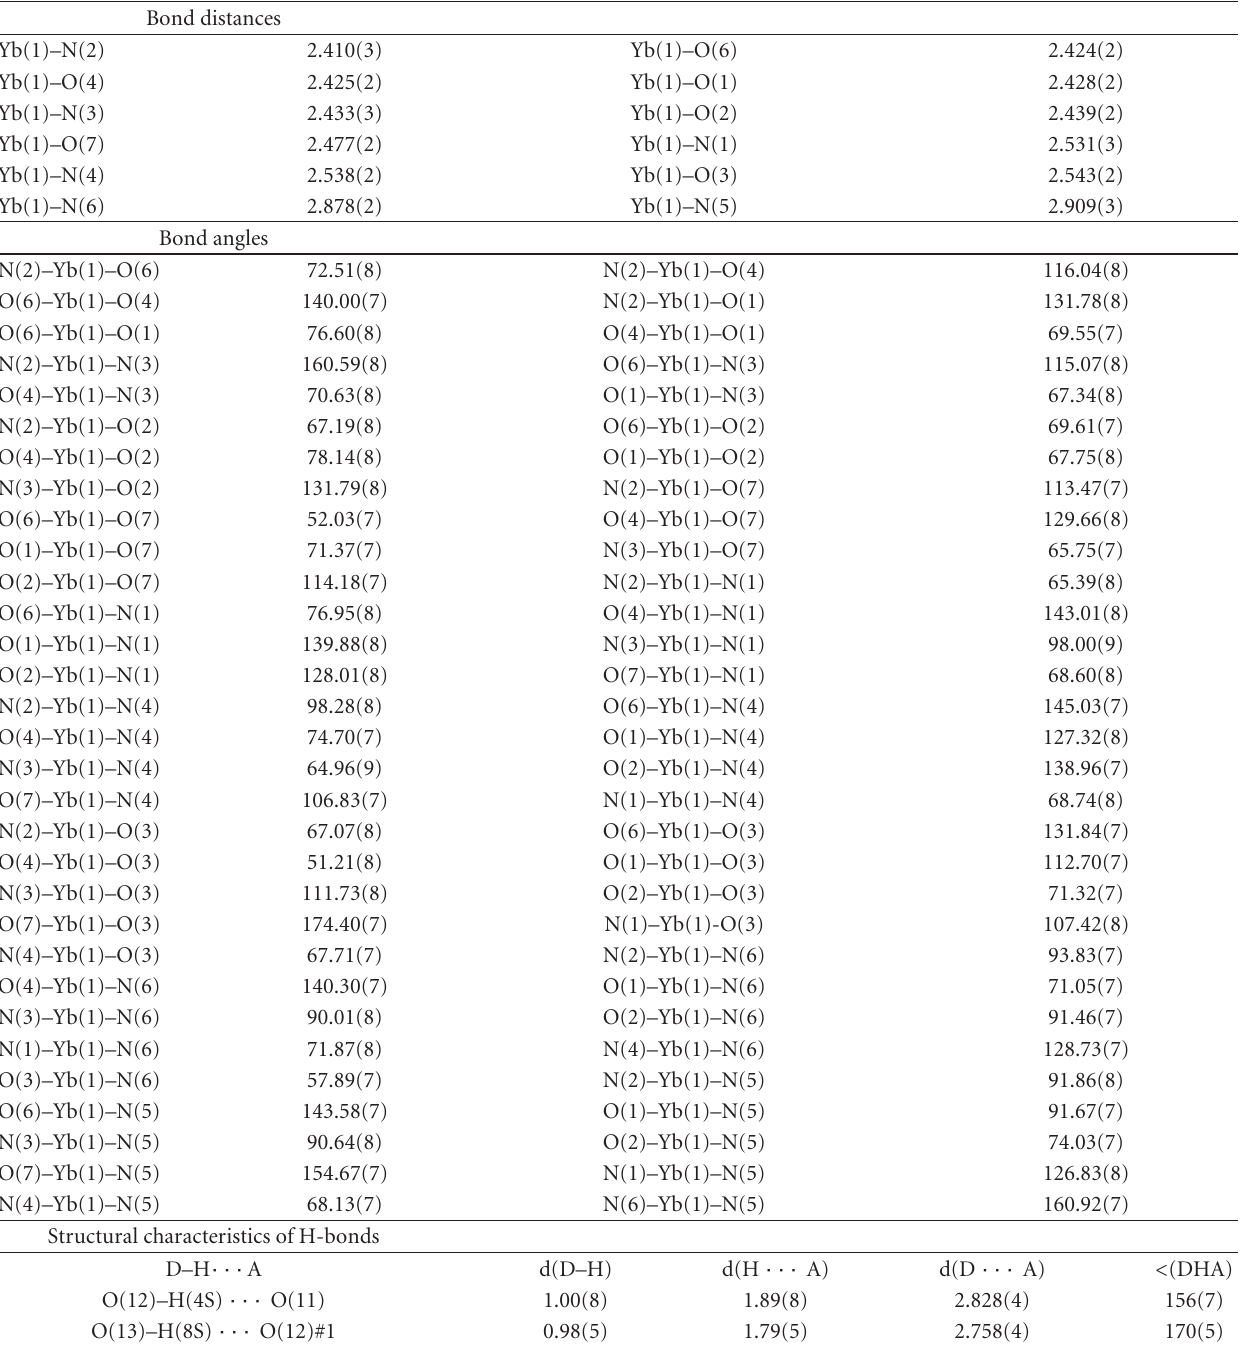
Table 2: Selected bond distances ( ˚A) and angles ( ◦ ) for [Yb(NO 3 ) 2 L](NO 3 ) · 2MeOH (4). Bond